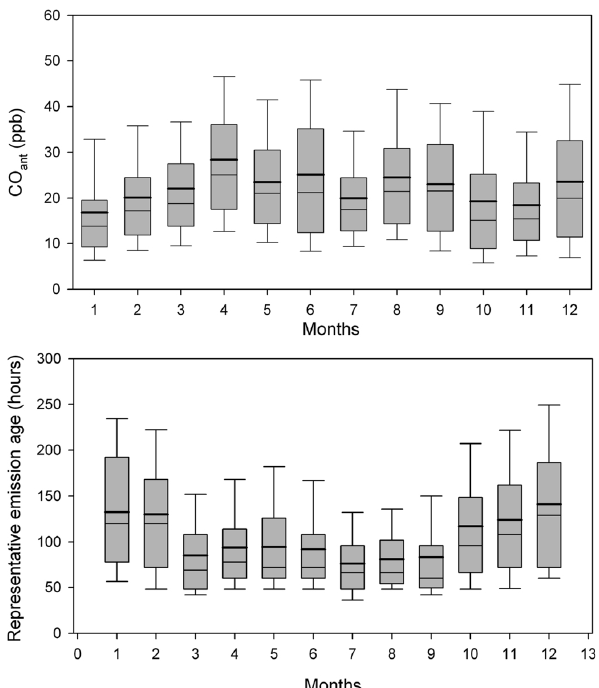
Fig. 6. Monthly distributions of FLEXPART daily CO ant (upper plot) with related representative emission ages (bottom plot) at ICO- OV during the period January 2007–July 2009. The boxes and whiskers denote the 10th, 25th, 50th, 75th and 90th percentiles. Bold lines represent average value. Data at 3-h resolution have been shown.